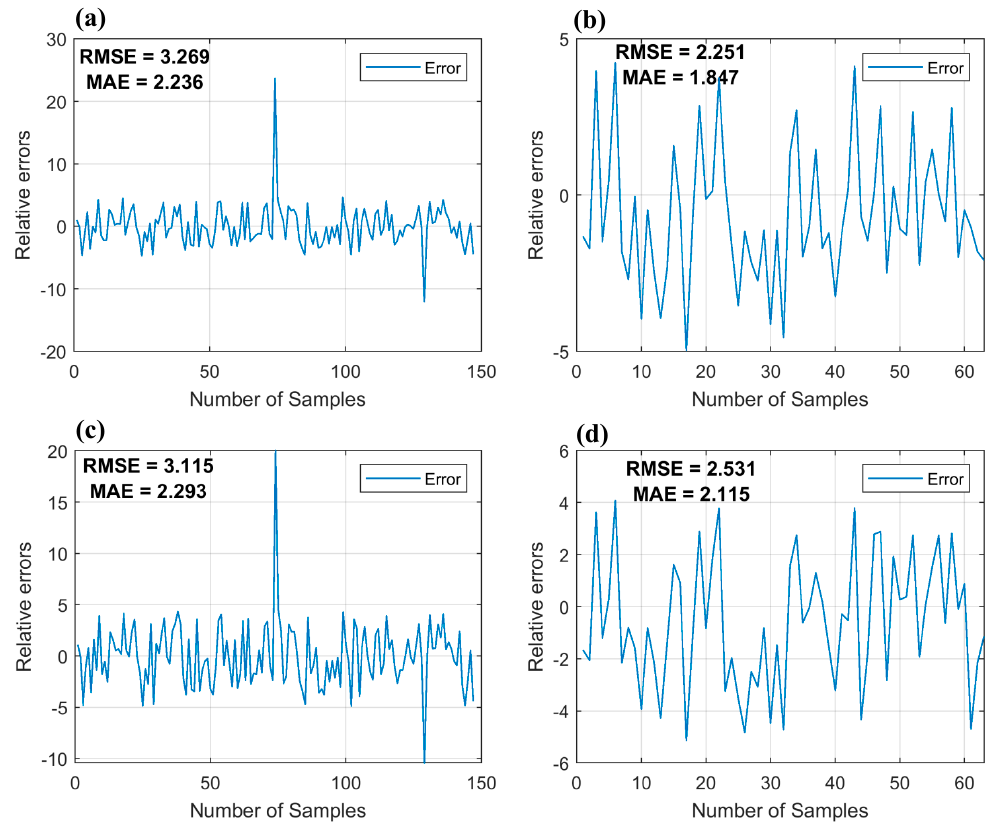
Figure 8. Error distribution of different models: ( a ) training PSOANFIS, ( b ) testing PSOANFIS, ( c ) training GAANFIS, and ( d ) testing GAANFIS.